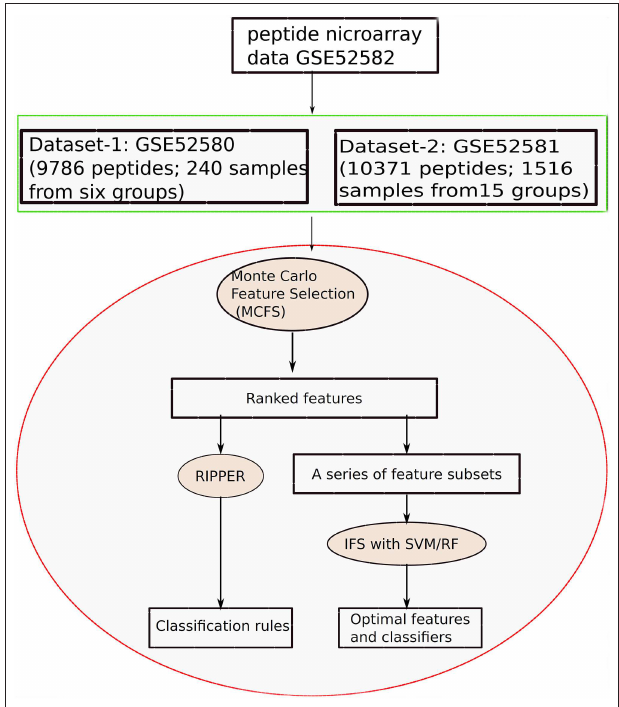
FIGURE 1 | Entire procedures to investigate the peptide microarray data from Gene Expression Omnibus with advanced machine learning